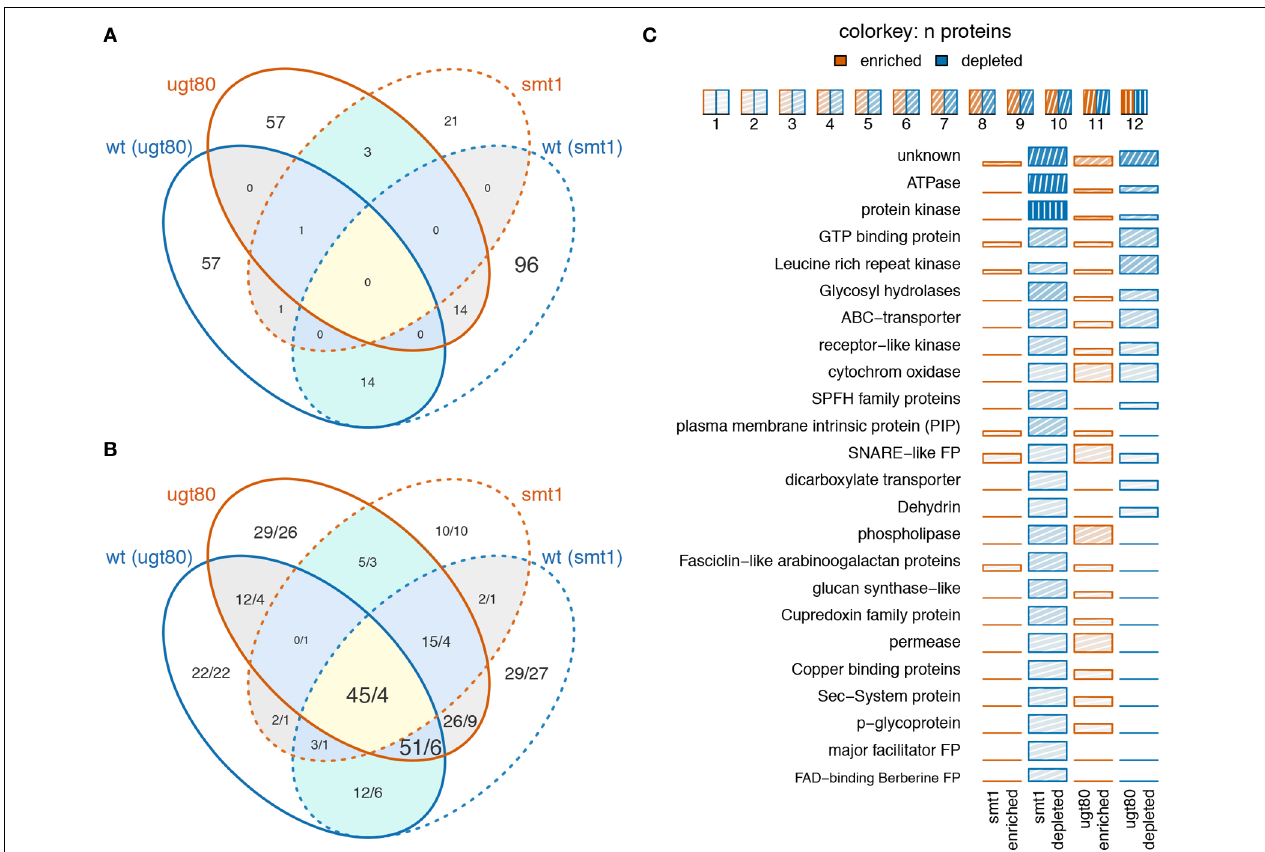
FIGURE 2 | Venn diagram displaying the number of overlapping proteins (A) or protein groups (B) being enriched (red) or depleted (blue) in smt1 or ugt80A2;B1 (ugt80) DRM fractions. Numbers in (B) indicate the number of unique proteins represented in the overlapping protein groups, separated by a slash. Low overlap was observed between proteins (A) but analysis based on protein groups showed a